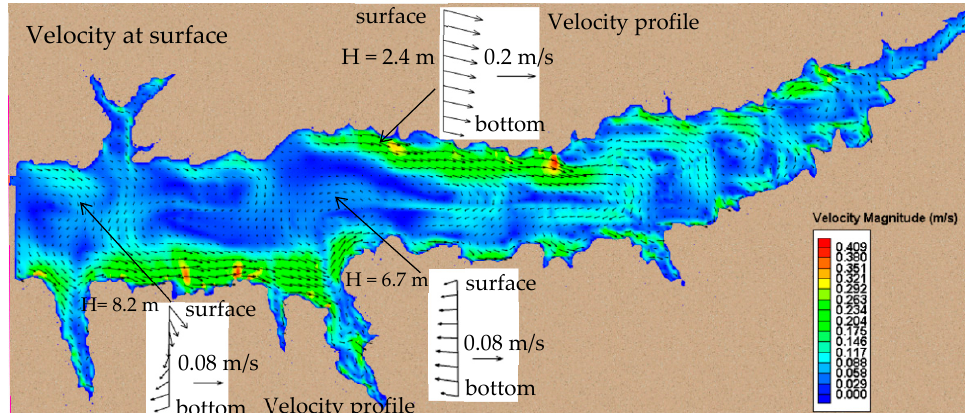
Figure 7. Simulated flow patterns at the water surface of Enid Lake.